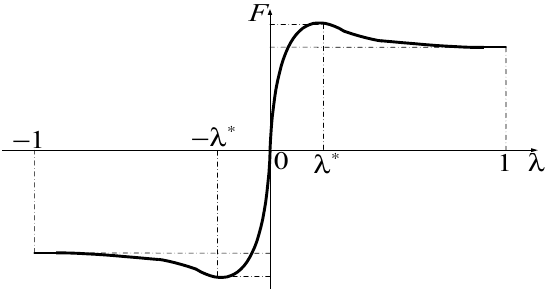
Figure 3. Nonlinear relationship between the driving force and the slip ratio.